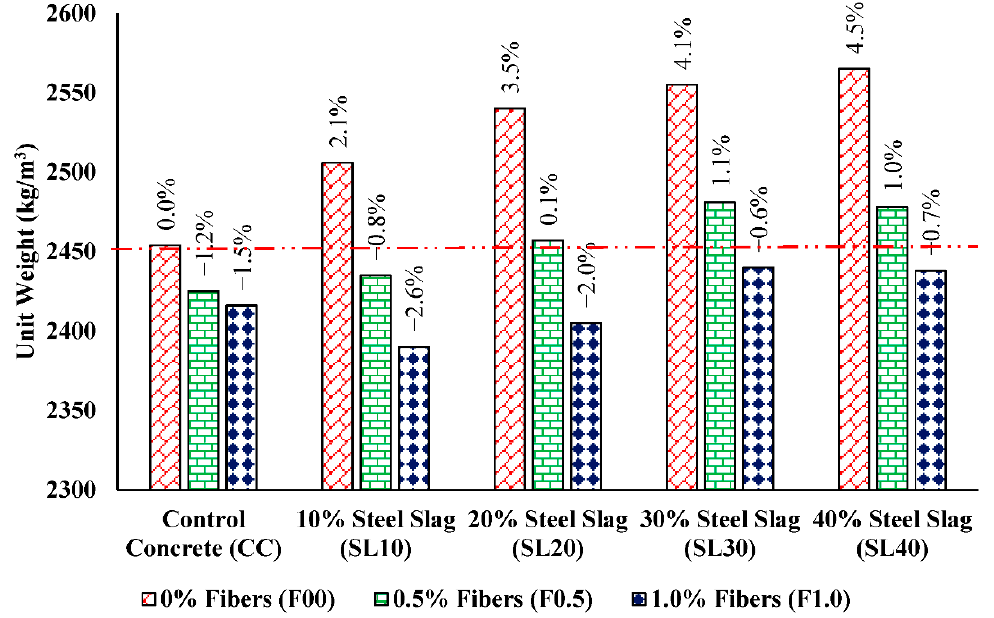
Figure 13. Comparison of dry unit weight results for all mixes.